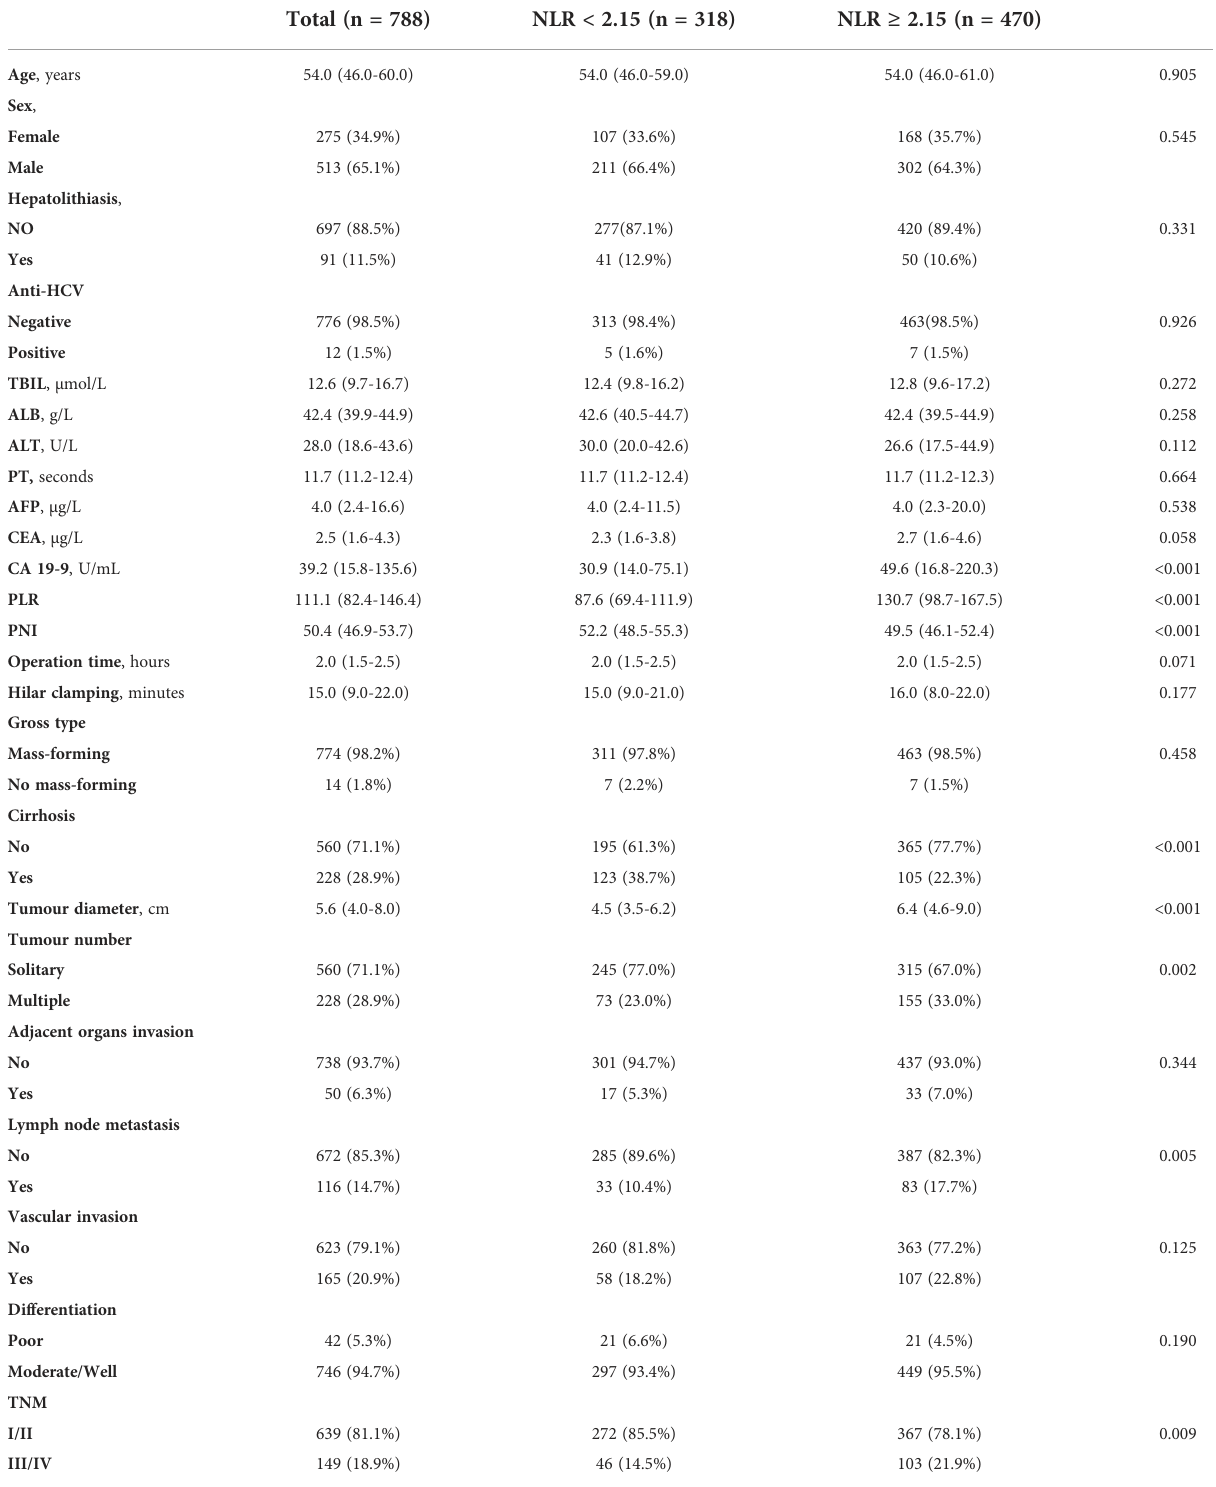
TABLE 5 Baseline clinicopathological data for HBV-ICC